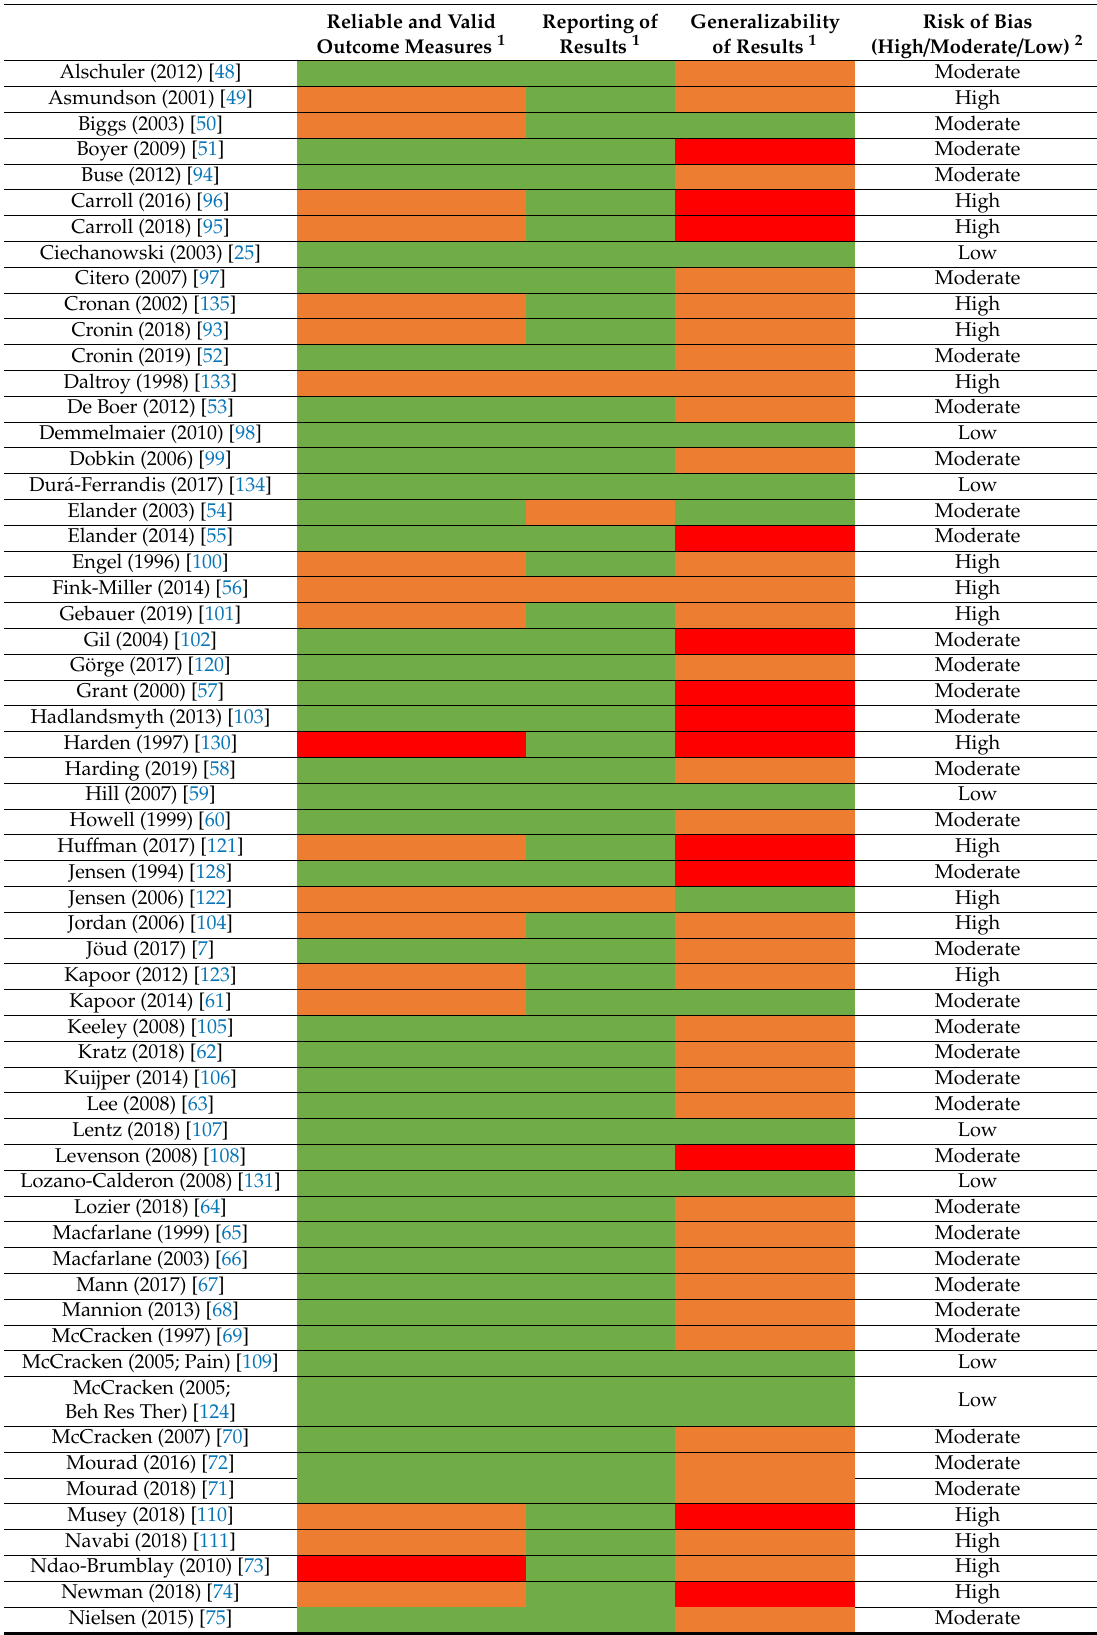
Table 2. Summarizing risk of bias